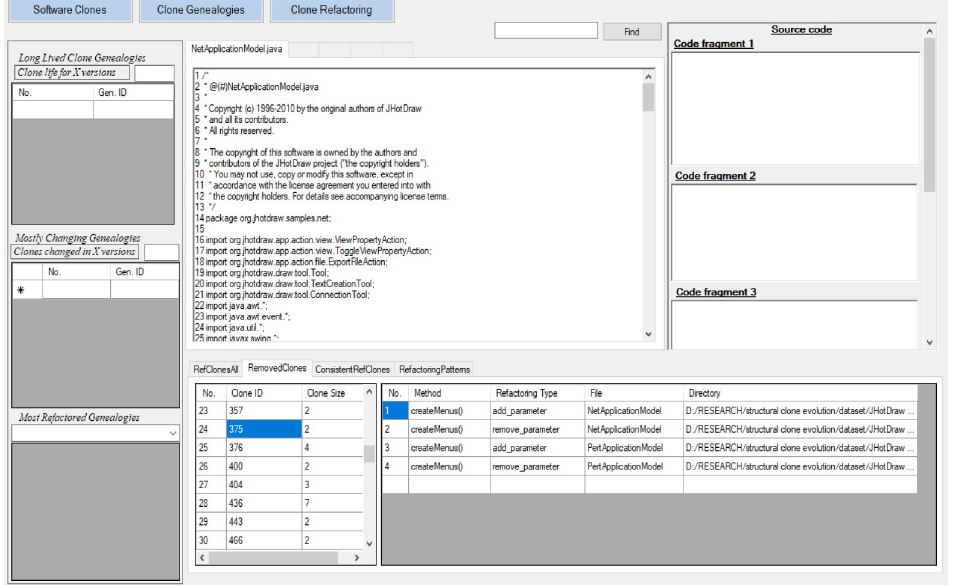
Fig 5. Screenshot of CRefEvol tool, RefactoredClones